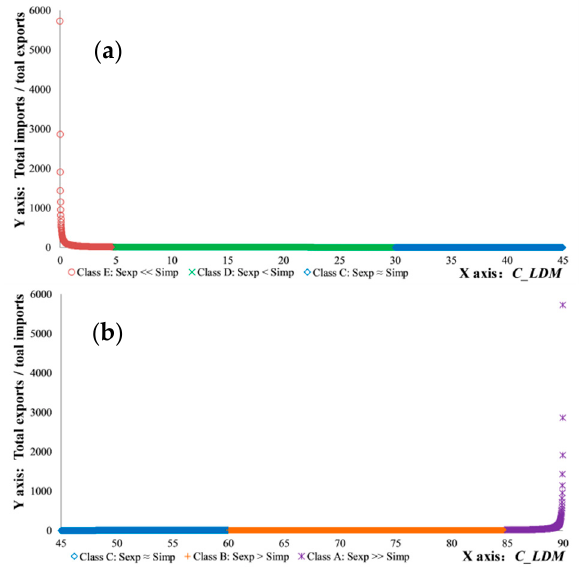
Figure A3. Heavy-tailed distribution of cot( C_LDM ) and tan( C_LDM ). ( a ) Heavy-tailed distribution of cot( C_LDM ). ( b ) Heavy-tailed distribution of tan( C_LDM ). In rank of C_LDM (unit: degree), we take 0.01 as the step size for sampling.